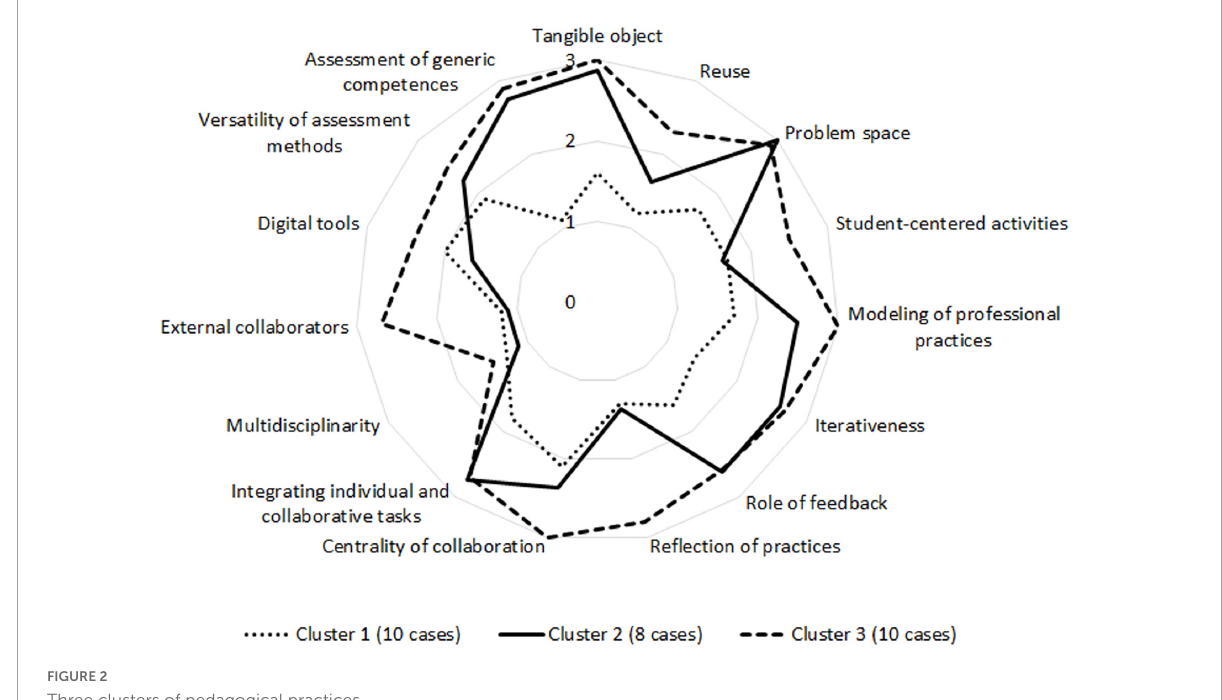
FIGURE2 Three clusters of pedagogical practices.